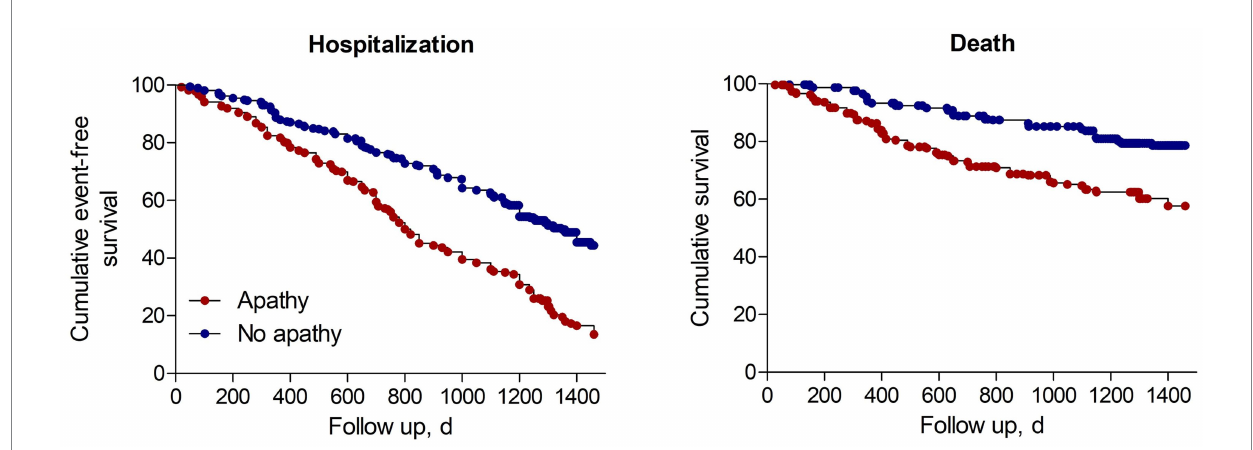
FIGURE 2 Cumulative event-free survival (Kaplan-Meyer curves) for hospitalization or death in dialysis patients.